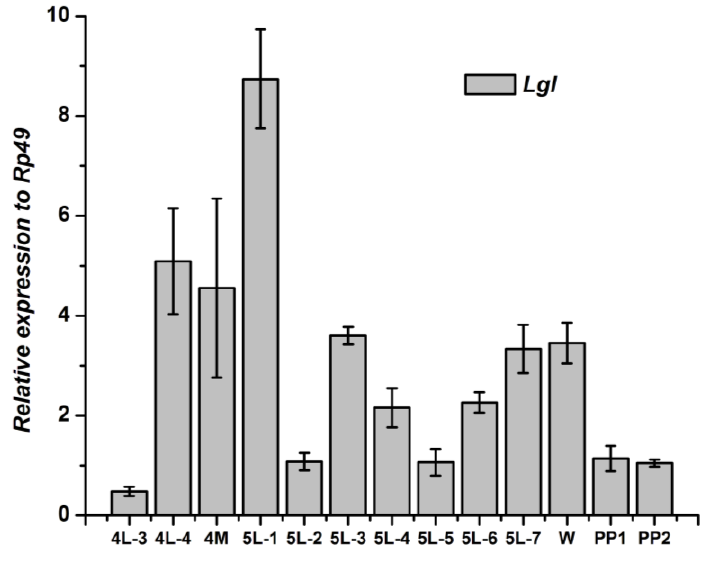
Figure 10. Developmental changes of Lgl mRNA in wingdisc of Bombyx